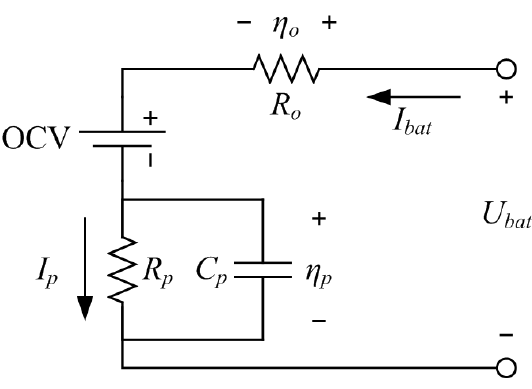
Figure 1. A resistance in series with a parallel resistance and capacitance (R-RC)